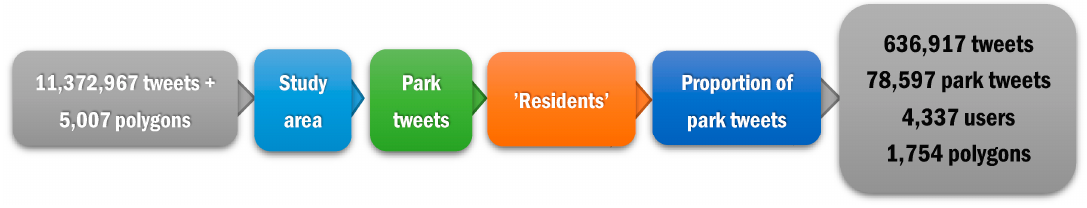
Figure 1. Overview of the data preprocessing workflow.